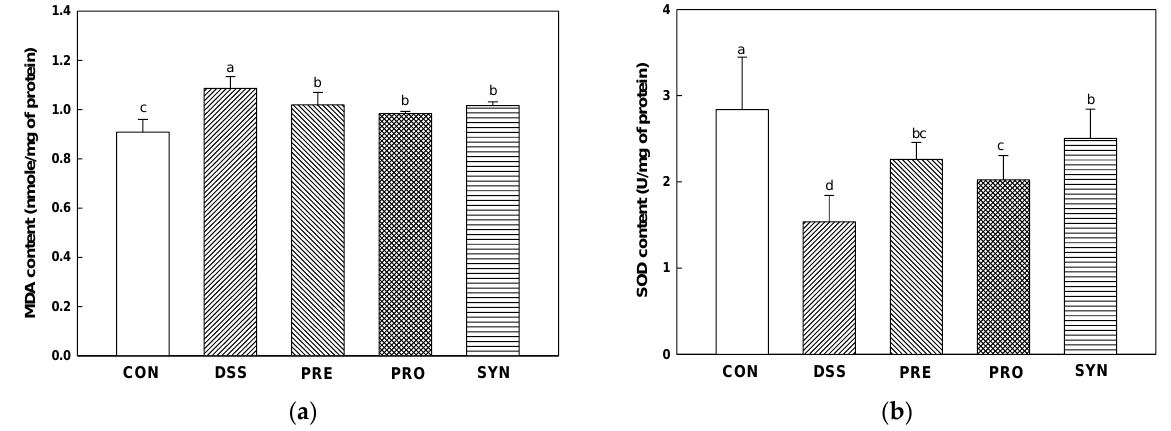
Figure 6. Effects of PRE, PRO, and SYN on antioxidant system of DSS-induced colitis mice. Malondialdehyde (MDA) content ( a ) and superoxide dismutase (SOD) level ( b ) in brain tissues. The results were presented as the mean ± SD ( n = 5). Data were statistically considered at p < 0.05, and different lowercase letters indicate significant differences between groups.